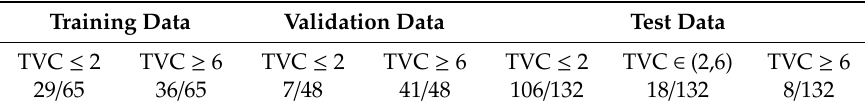
Table 1. Dataset composition for multispectral imaging (MSI) data. Training and validation samples having TVC counts in the range (2, 6) log CFU / g have been excluded from the analysis. Test dataset is analyzed in total.